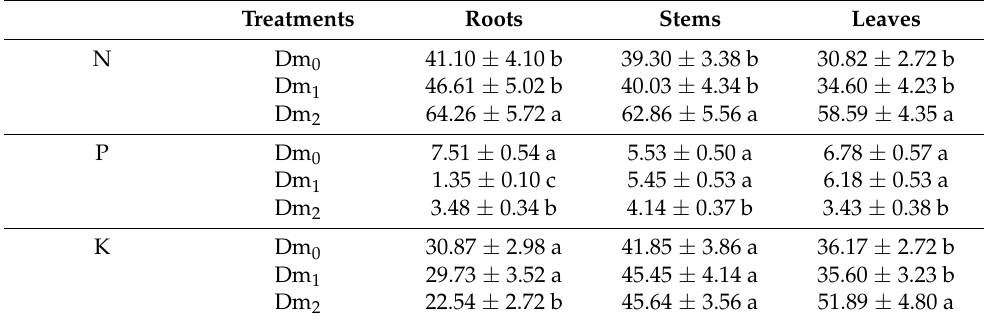
Table 6. The effects of different fertigation treatments (Dm 0 —standard nutrient solution, Dm 1 —raw leachate treatment, and Dm 2 —raw leachate blended with H 2 O 2 treatment) on nutrient concentrations (expressed in mg g − 1 DW) in roots, stems, and leaves in D. marginata plants at the end of the experiment. The results are expressed as means ± standard deviation ( n = 4). In each column, the same letters indicate non-significant differences ( p < 0.05).